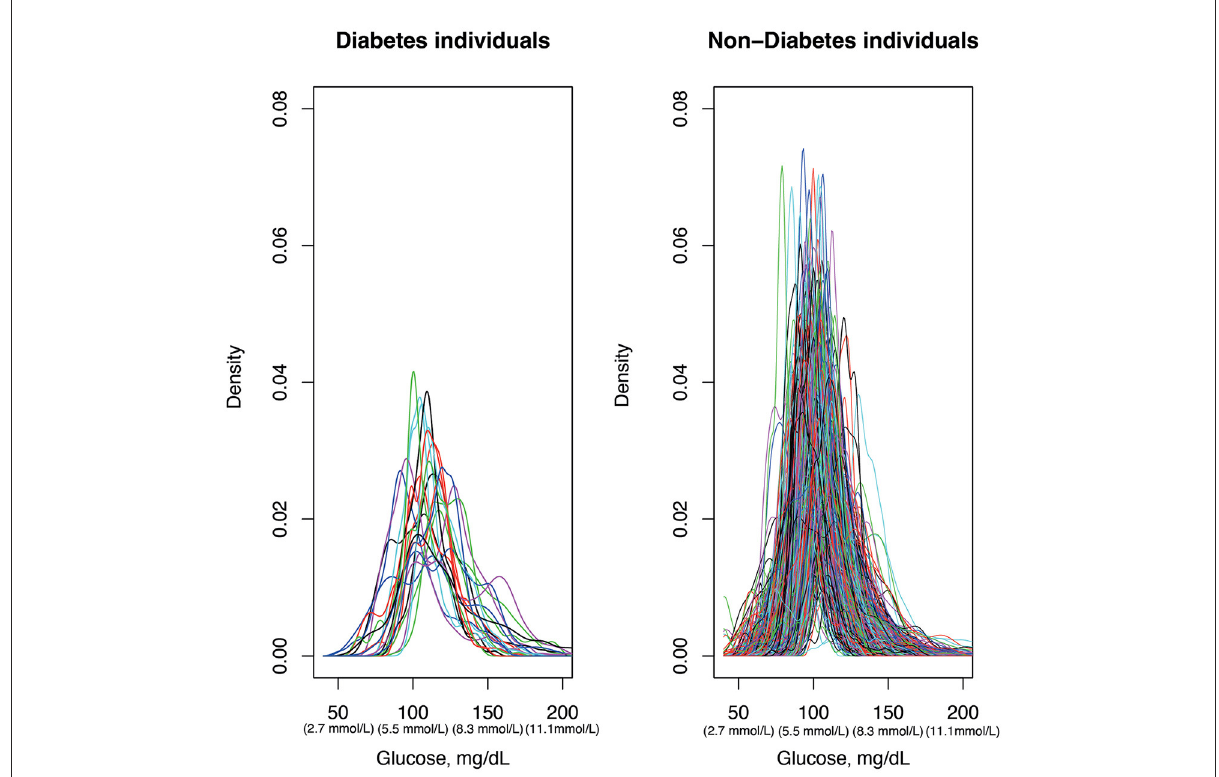
FIGURE2 Glucodensities. Interstitial glucose data obtained from continuous glucose monitoring. For each patient, glucose representation estimates the proportion of time spent at each glucose concentration over a